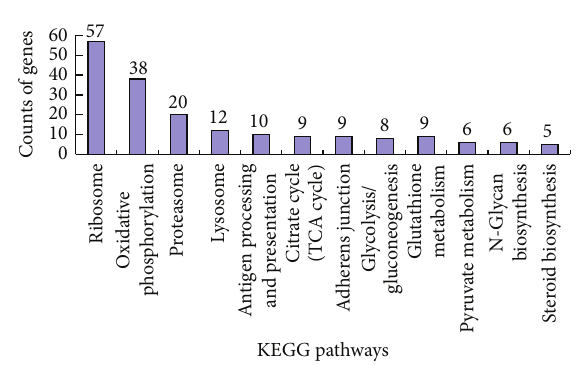
Figure 2: Highly expressed genes KEGG pathways analysis.